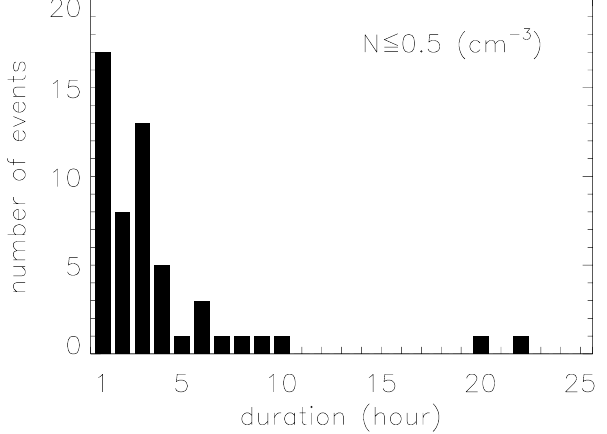
Fig. 2. A histogram of duration of low solar wind density events with density 0.5 cm − 3 or less.